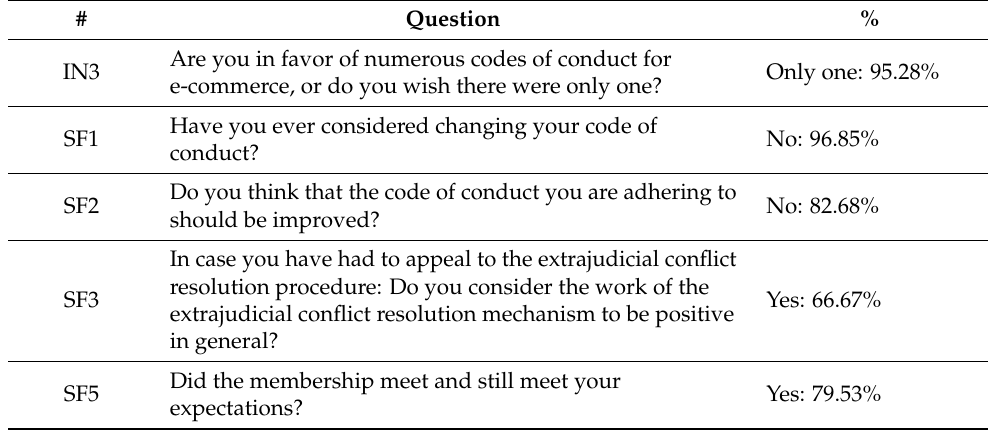
Table 5. Responses (dichotomous variables).